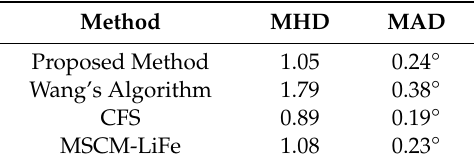
Table 2. Accuracy of the compared methods.